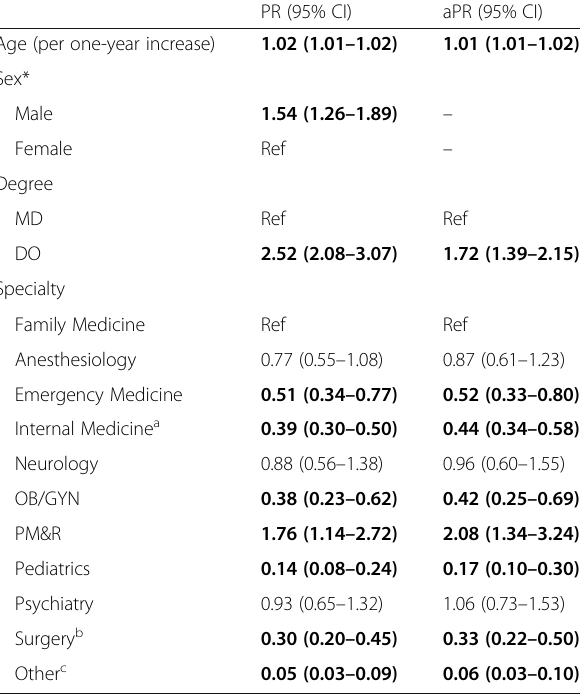
Table 4 Crude and Adjusted Prevalence Ratios using the